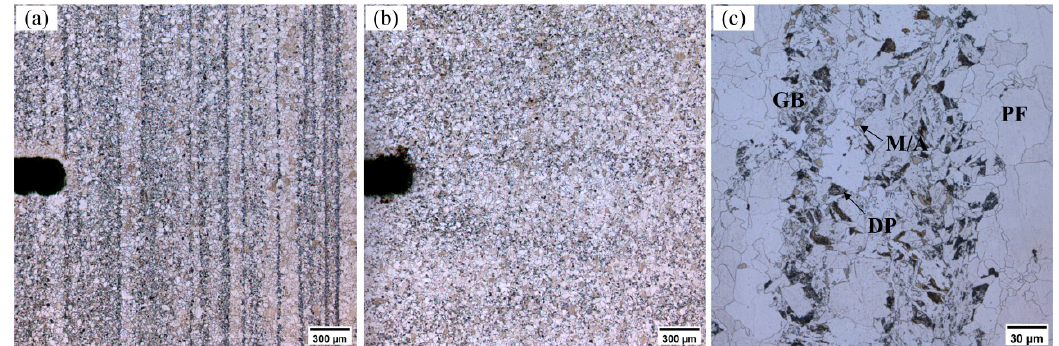
Figure 2. Optical micrographs of specimens: ( a ) banded structure around the notch tip in LD; ( b ) banded structure around notch tip in TD; ( c ) micrographs of different phases in banded structure.